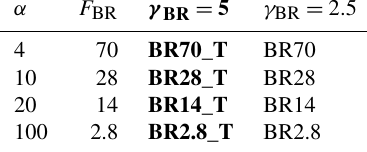
Table 1. Sensitivity settings for the collisional breakup parame- terization. α is the scale factor, F BR the fragments generated and γ BR the decay rate of the fragment number at warmer temperatures. Shown in bold is γ BR = 5, as used by Sullivan et al. (2018a). α F BR γ BR = 5 γ BR = 2 .